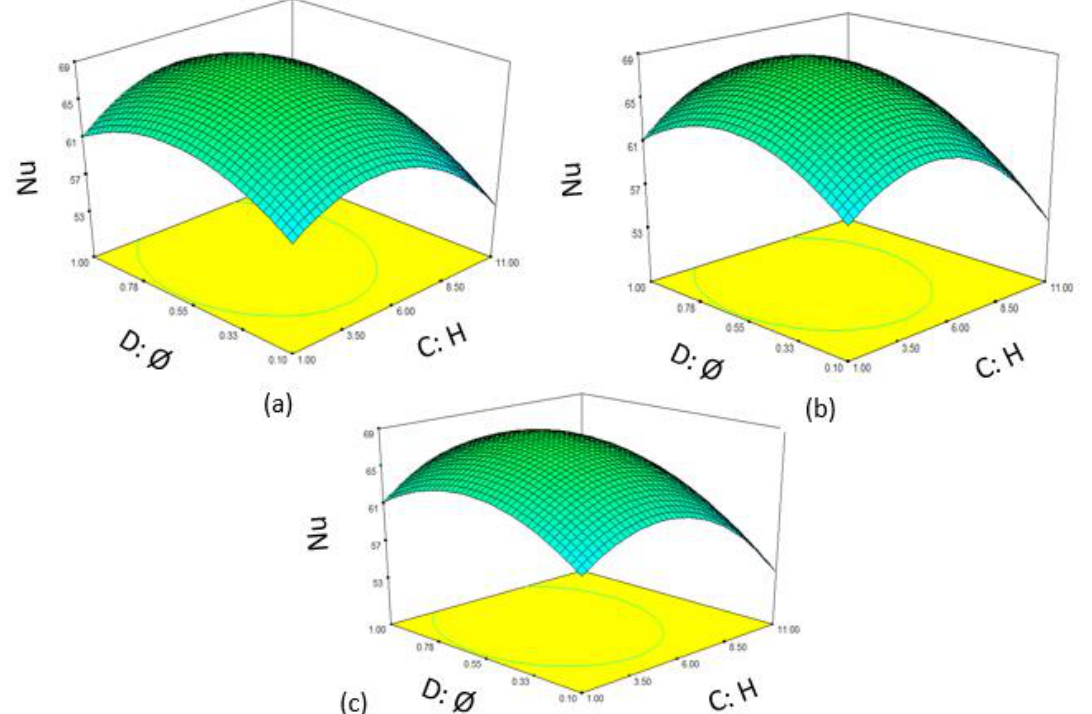
Figure 13. Nusselt number contours and 3D surface formed by the effect of the nozzle-plate distance and Nano concentration at the optimum conditions for the optimization target of maximum Nusselt number and nanoconcentration equal to ( a ) 0.1%; ( b ) 0.5%; ( c ) 1%.